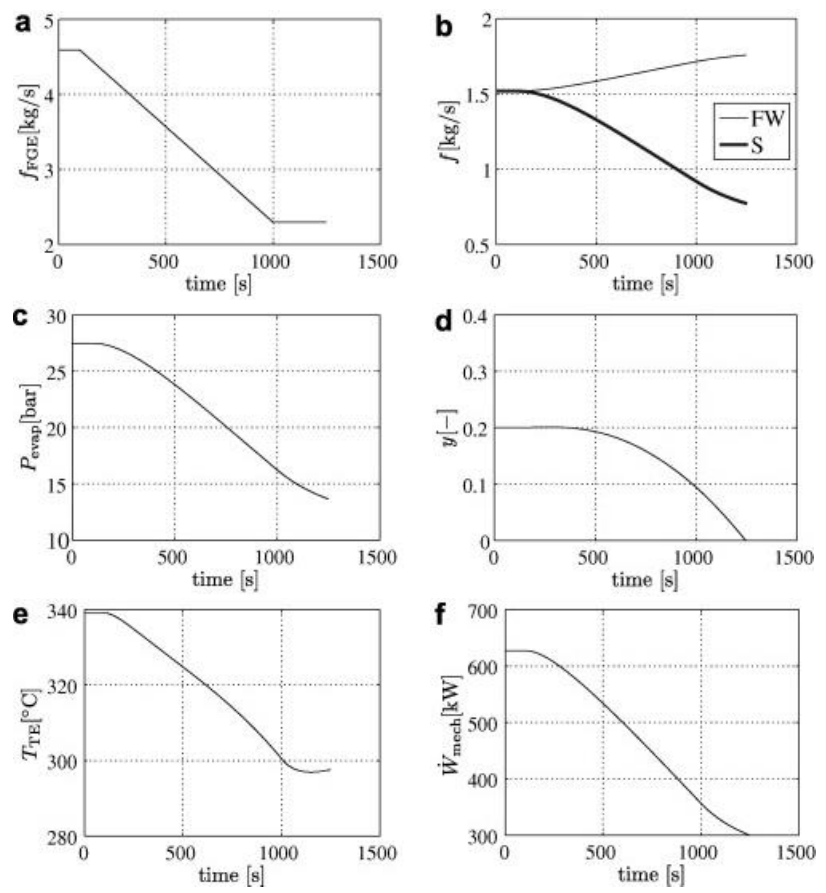
Figure 5. Transients for a 50% ramp decrease of the entering flue-gas mass flow at design conditions: ( a ) ramp on flue-gas mass flow ( f FGE ); ( b ) feedwater ( f FW ) and steam ( f C ) mass flows; ( c ) evaporator pressure ( P evap ); ( d ) volume fraction of steam inside the evaporator ( y ); ( e ) turbine-inlet temperature ( T TE ) and ( f ) turbine mechanical ( 𝑾̇ mech ); Reprint with permission [65]; 2007, Elsevier.